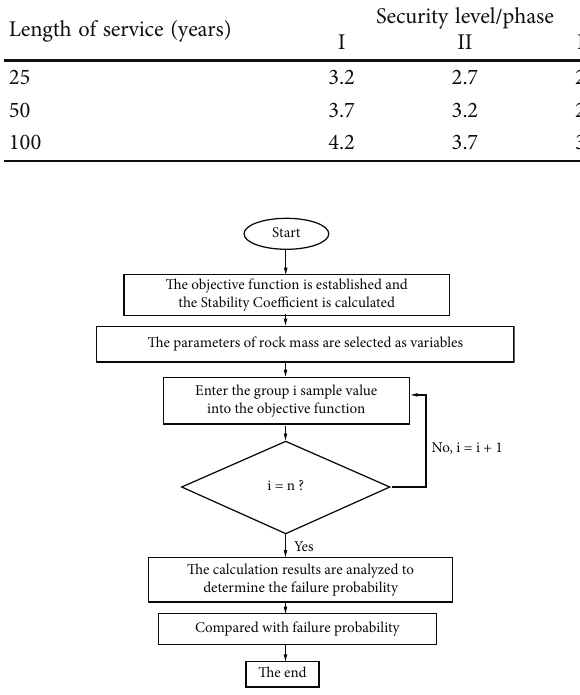
Figure 9: Flowchart of the MCS